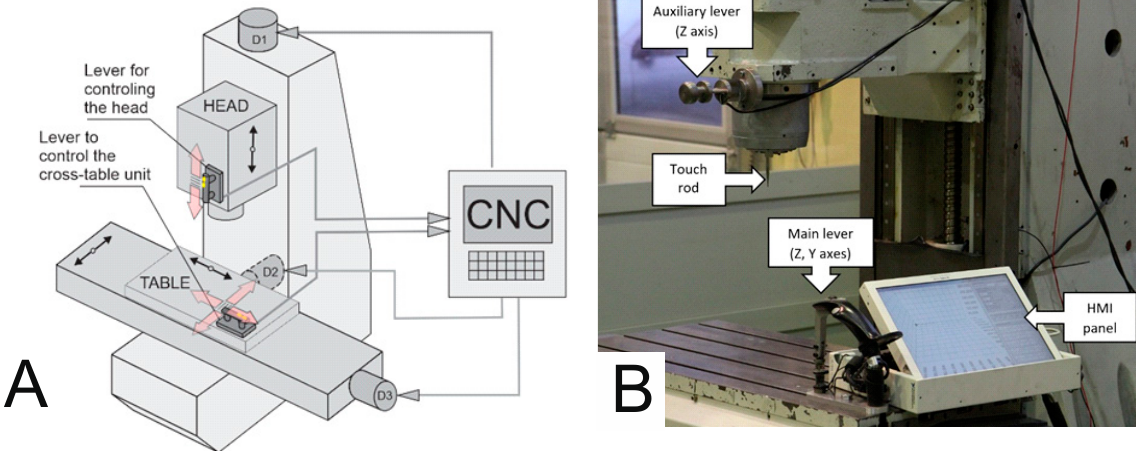
Figure 1. ( A ) Schematic diagram of the CMGS system, ( B ) input interfaces to the CMGS system. In the natural human environment, the movement of objects in space is not